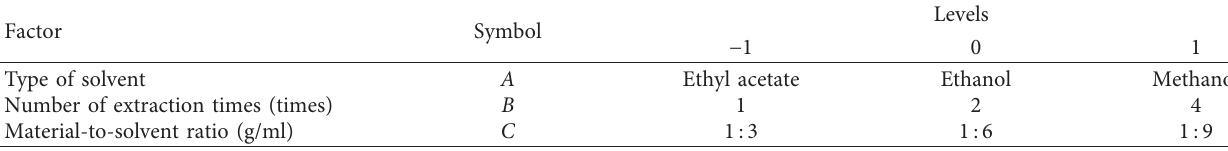
Table 1: Box–Behnken design for the optimization of extraction